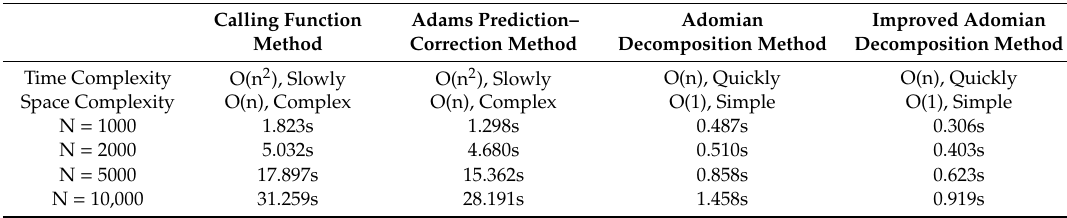
Table 1. Performance comparison of different algorithms.